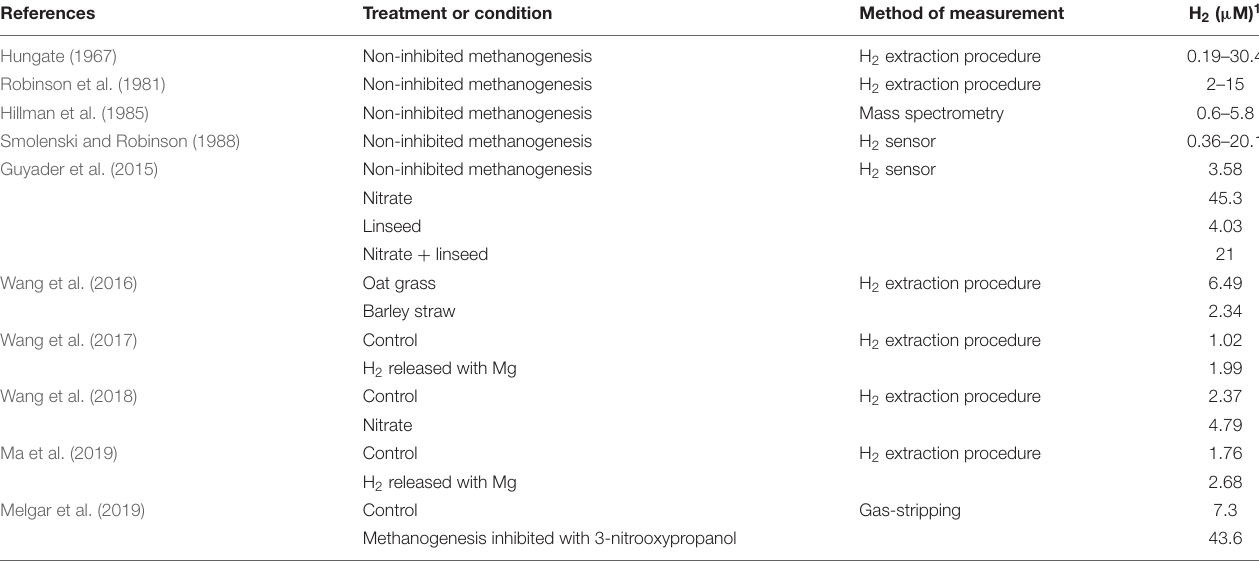
TABLE 1 | Dissolved dihydrogen concentration in the